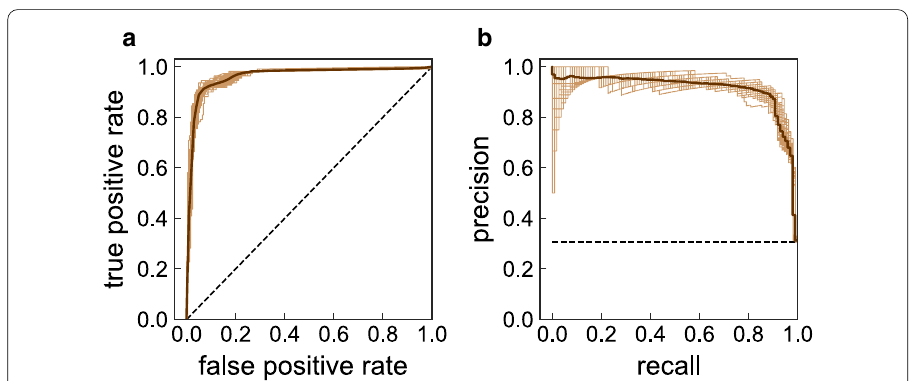
Fig. 9 ROC and PR curves when the normal users and those involved in fictive transactions are classified. a ROC curves. b PR curves. Each thin line corresponds to one of the 100 classifiers. The thick lines correspond to the average of the 100 lines. The dashed lines correspond to the uniformly random